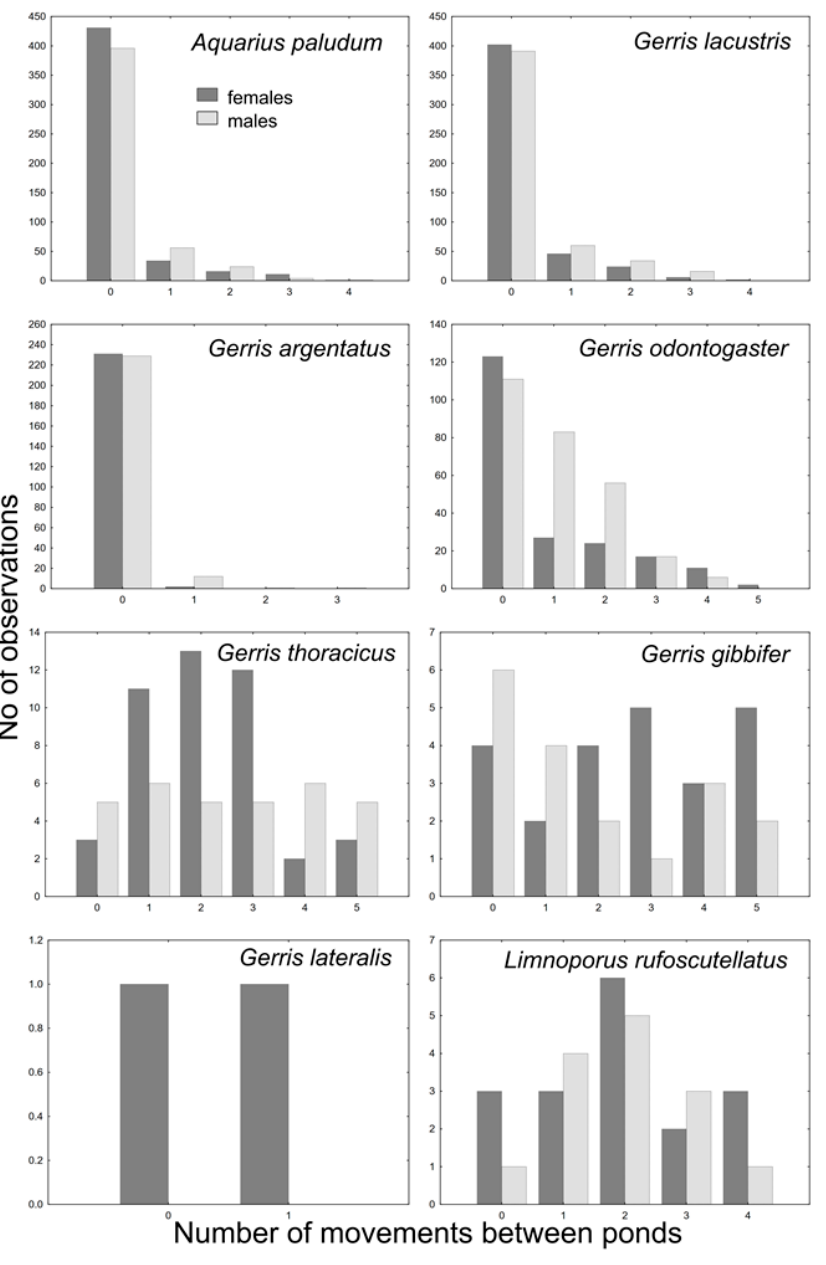
Figure 6. Movements between ponds in all recaptured species (intersite movements); only macropterous bugs were marked and recaptured.